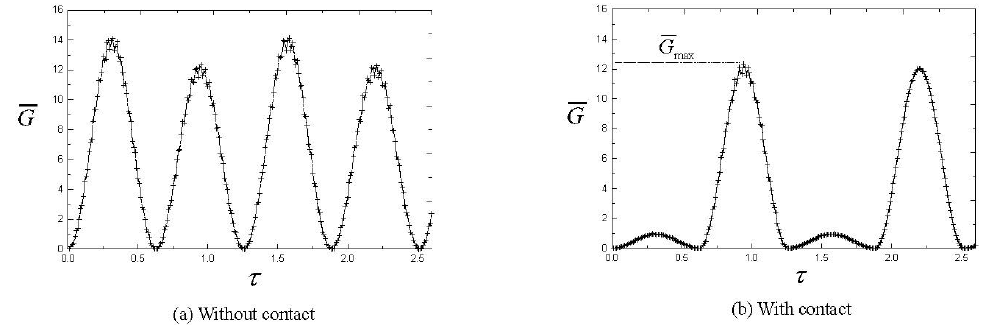
Figure 3. Effect of contact on energy release rate of delaminated piezoelectric